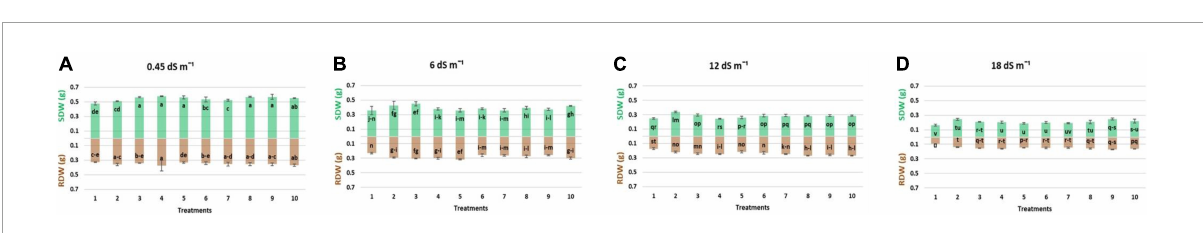
FIGURE4 Effect of multi-strains inoculum on shoot dry weight: SDW (g plant − 1 ) and root dry weight: RDW (g plant − 1 ) of wheat in the presence of salinity under the axenic condition. (A–D) Different levels of